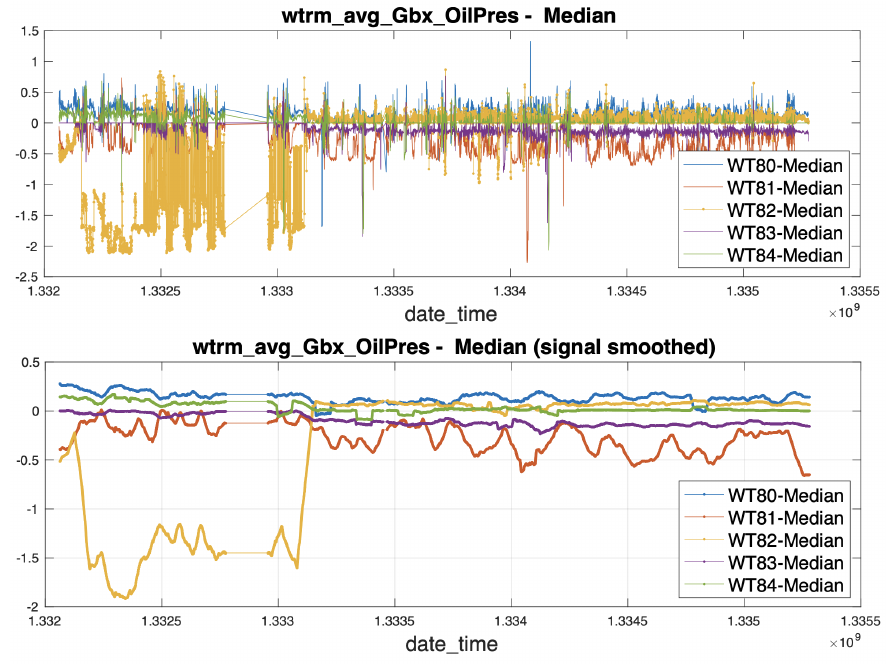
Figure 9. At the top, the residue of the signals wtrm_avg_Gbx_OilPress is depicted. The same signals smoothed by a 50-sample moving average filter are depicted at the bottom.